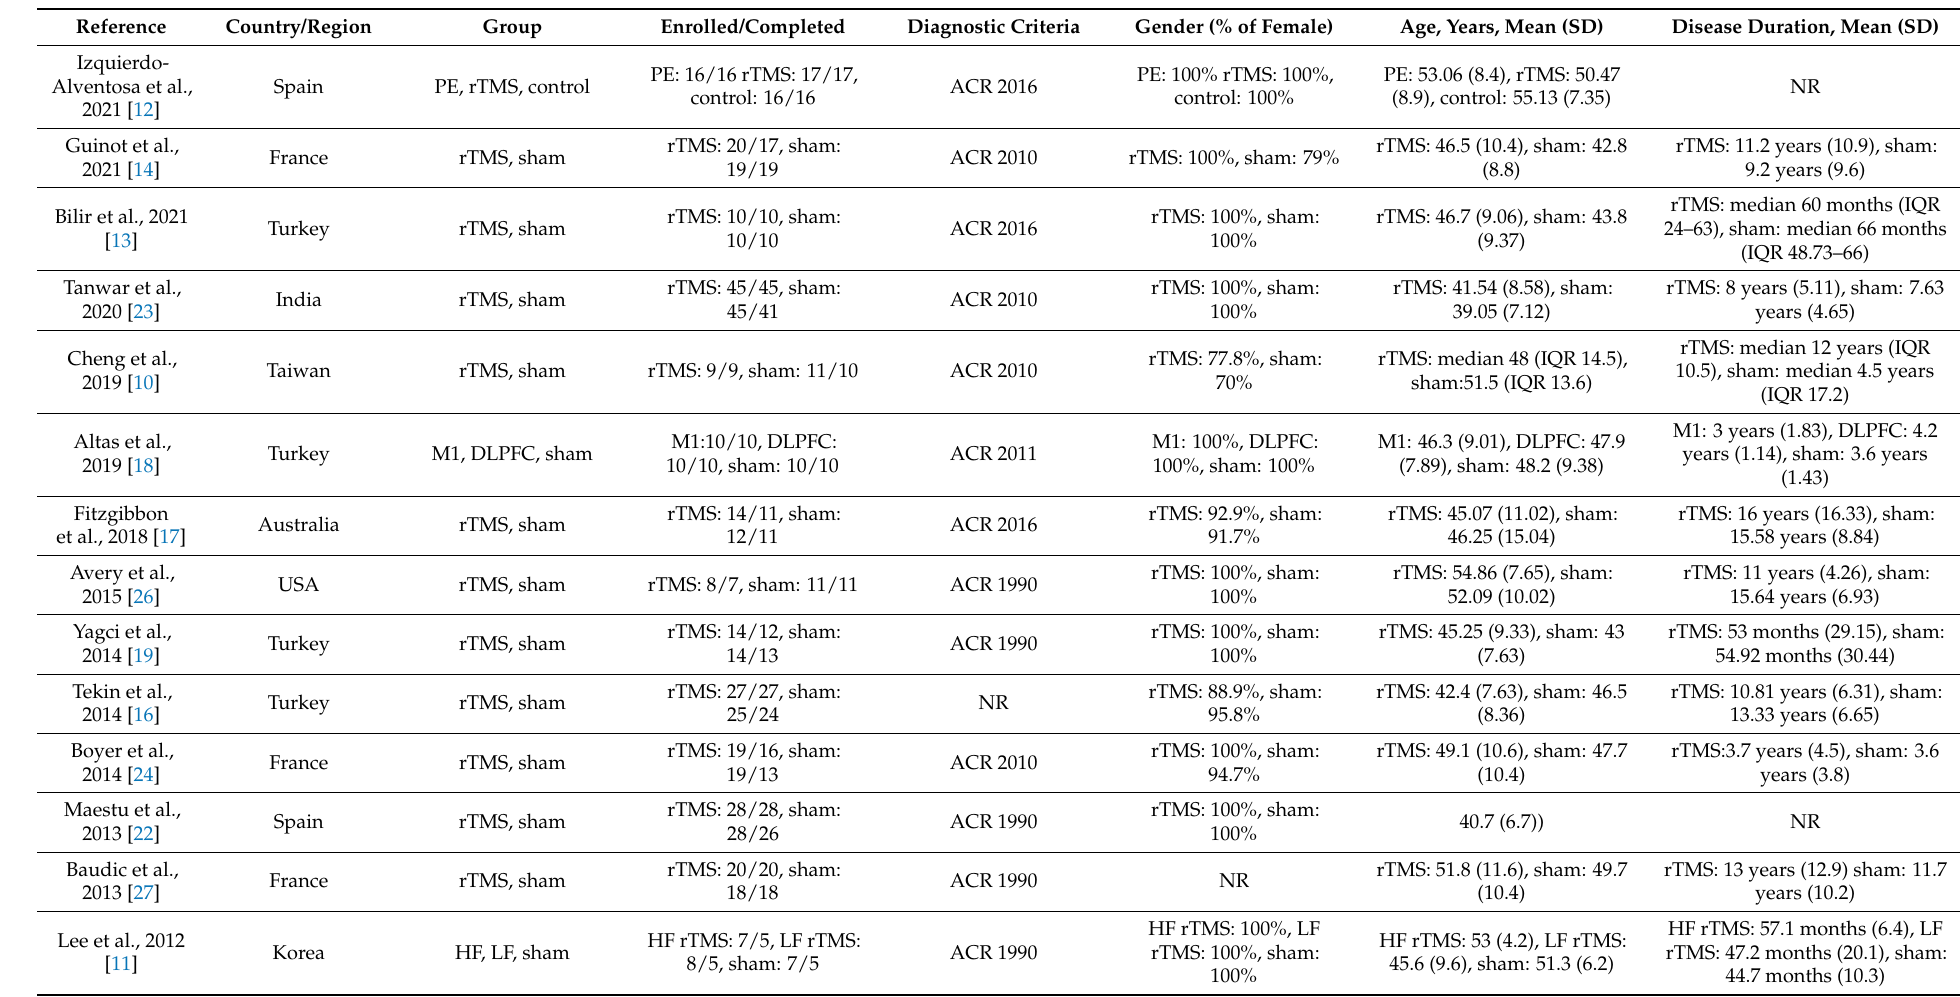
Table 1. Characteristics of all included